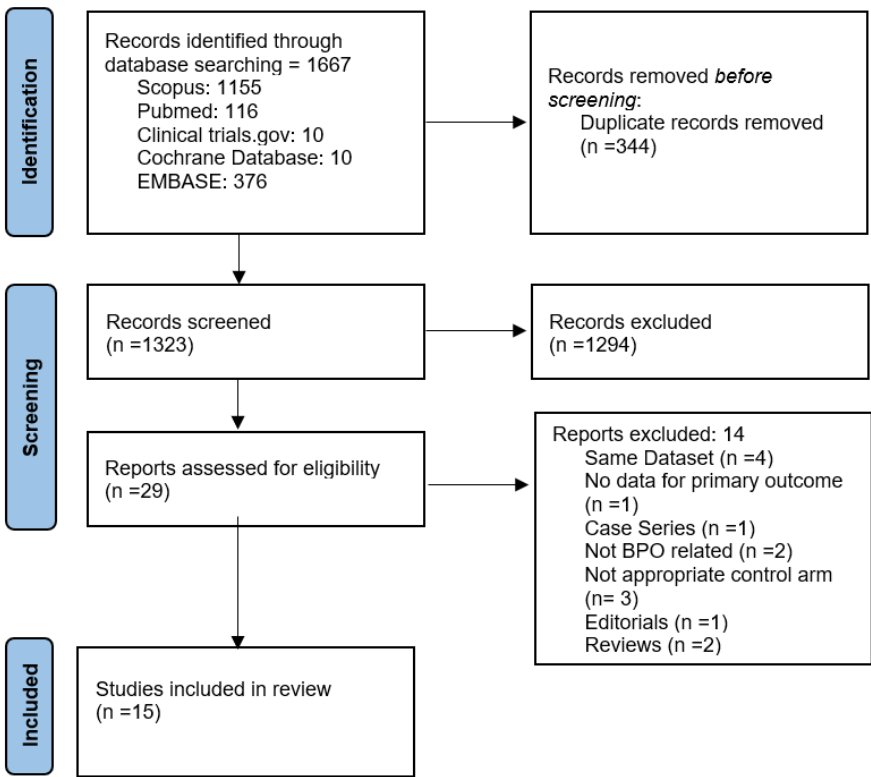
Figure 1. Prisma flow diagram of study-selection process. Across included studies, the mean patient age ranged from 57 to 71 years of age, while the mean follow-up ranged from 29 to 52 months. Two RCTs compared concomitant TURBT and TURP versus TURBT and medical therapy for BPO [21,31], whereas the remaining studies compared TURBT and transurethral prostate surgery versus TURBT alone. In particular, in 13 studies, BPO was managed by TURP, while in 1 study, it was managed with photo-selective vaporization of the prostate and in another it was managed with thulium laser enucleation [28,34]. Interestingly, in those two studies where BPO was not managed with TURP, postoperative single-instillation intravesical chemotherapy was administered. Overall, a total of 1041 patients underwent concomitant surgery. Of them, 489 patients (47%) presented with bladder tumors and known BPO; in 45 (4.5%), concomitant TURP was undertaken to enable access to bladder tumors at certain locations within the bladder; and 16 (1.5%) underwent TURBT during elective surgery for BPO due to incidental finding of bladder tumors. In the remaining 491 cases (47%), the reason for concomitant surgery was not reported. The baseline characteristics of all included studies are displayed in Table 1. Based on the RoB-2 tool, all RCTs displayed some methodological concerns. Based on the NOS, eight non-RCTs were considered of good quality [24,26,27,29,30,32–34], three of moderate quality [20,22,23], and one of poor quality [25]. The detailed quality assessment is depicted in Supplementary Material